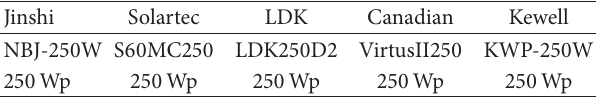
Table 2: 250 Wp PV panel of different manufacturers.